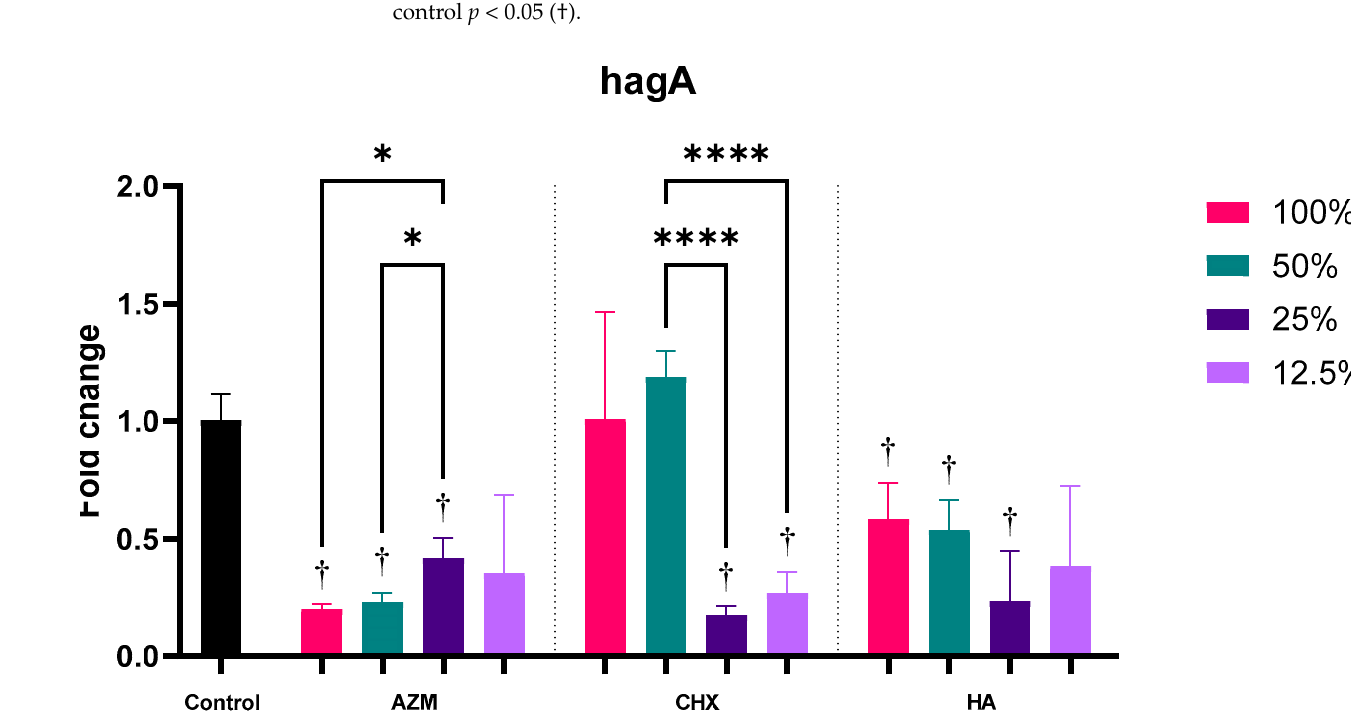
Figure 5. Fold-change values (mean ± SD) of different concentrations on expression of mfa1. >0.05 (ns), ≤ 0.05 (*), ≤ 0.01 (**), ≤ 0.001 (***), ≤ 0.0001 (****). Statistically significant compared to control p < 0.05 (†).